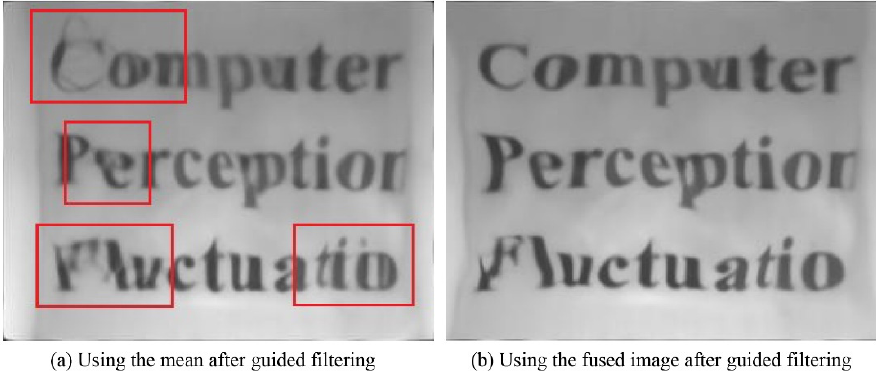
Figure 5. The results after five iterations of our method. ( a ) Use the mean as the reference after guided filtering. ( b ) Use the fused image as the reference after guided filtering.